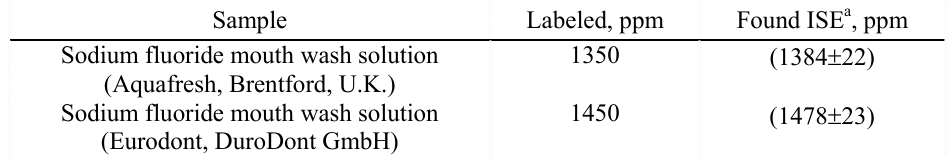
Table 4. Fluoride ions determination in mouth wash solutions Sample Labeled, ppm Found ISE a ,